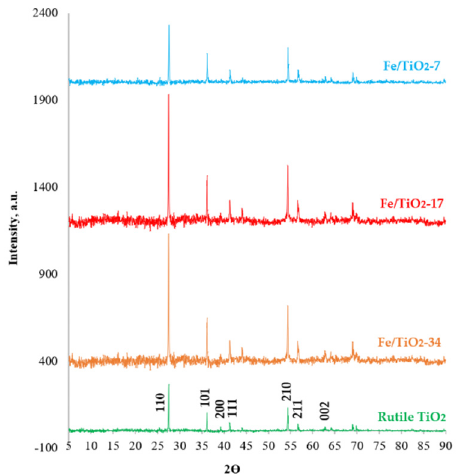
Figure 2. X-ray diffraction patterns of the rutile TiO 2 (Rutile), ball-milled TiO 2 (Rutile-7), and Fe/TiO 2 (B/P = 7, 17, and 34) prepared by mechanochemical ball-milling at 400 rpm for 10 h.